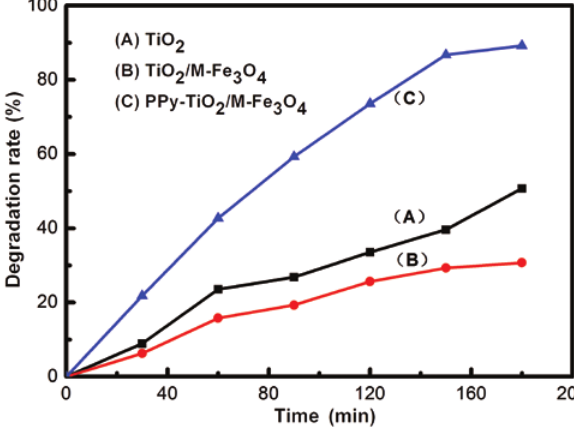
Figure 6 Methyl orange degradation rate-time curves under sunlight.